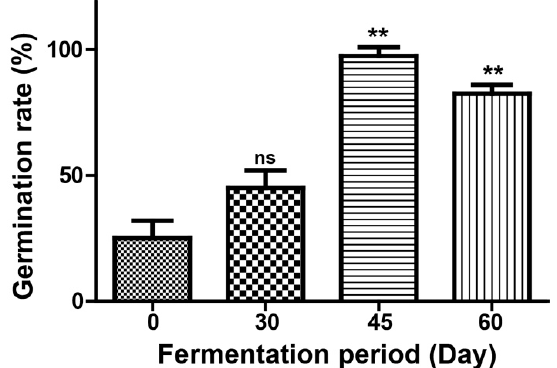
Figure 1. Effect of fermentation period [unfermented oak tree sawdust (0), 30-day fermented oak tree sawdust (30), 45-day fermented oak tree sawdust (45), and 60-day fermented oak tree sawdust (60)] on the seed germination rate. Each fermentation period was statistically compared with 0 day. The asterisks indicate significant difference (** p < 0.01 ). ‘ns’ indicates ‘not significant’.